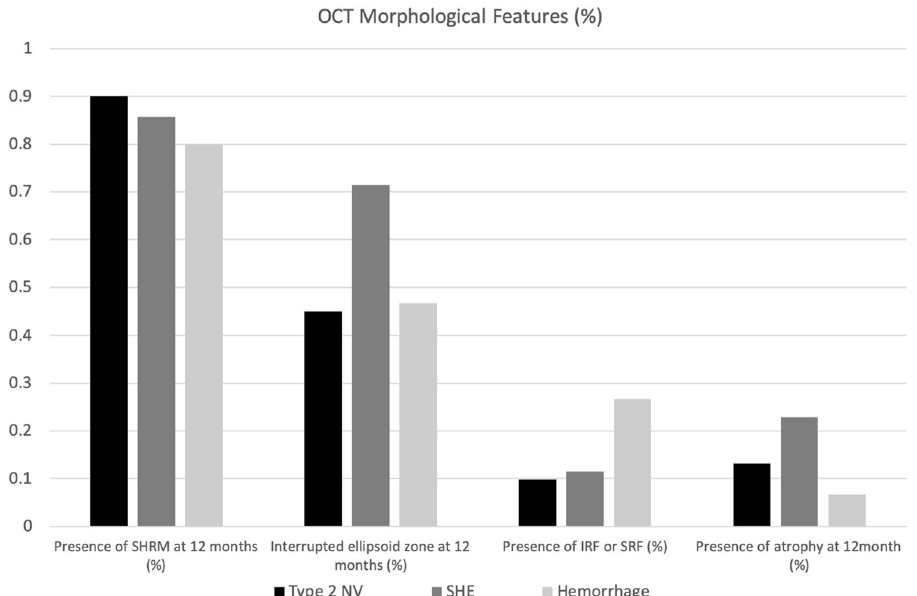
Figure 5. Morphological features on OCT according to different SHRM types after 1 year of treatment. OCT optical coherence tomography, SHRM subretinal hyperreflective material, IRF intra-retinal fluid, SRF subretinal fluid, NV neovascularization, SHE subretinal hyperreflective exudation, OCT optical coherence tomography.